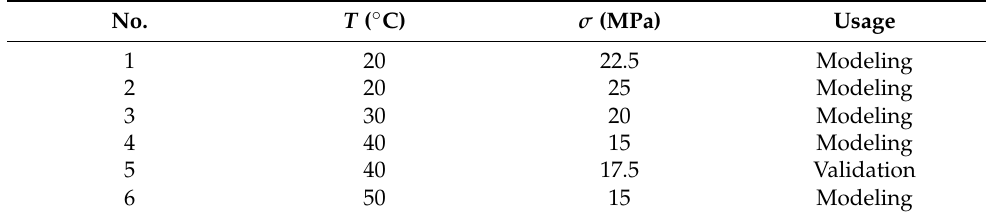
Table 1. Testing conditions and data